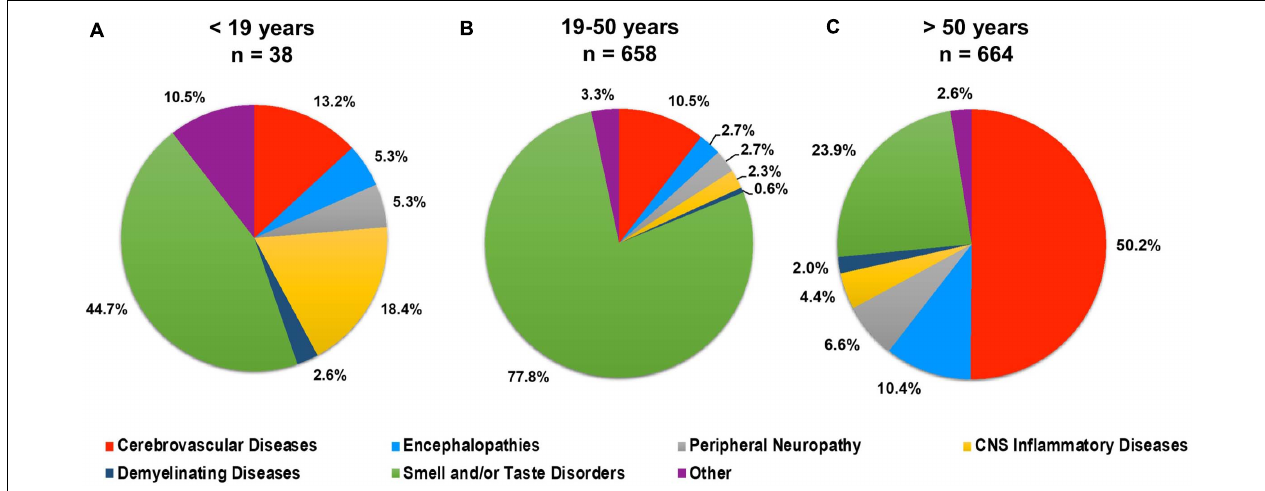
FIGURE 3 | Percent of total neurological conditions ( n = 1,360) occurring in (A) children ( < 19 years), (B) young adults (19–50 years), and (C) older adults ( > 50 years) diagnosed with COVID-19.